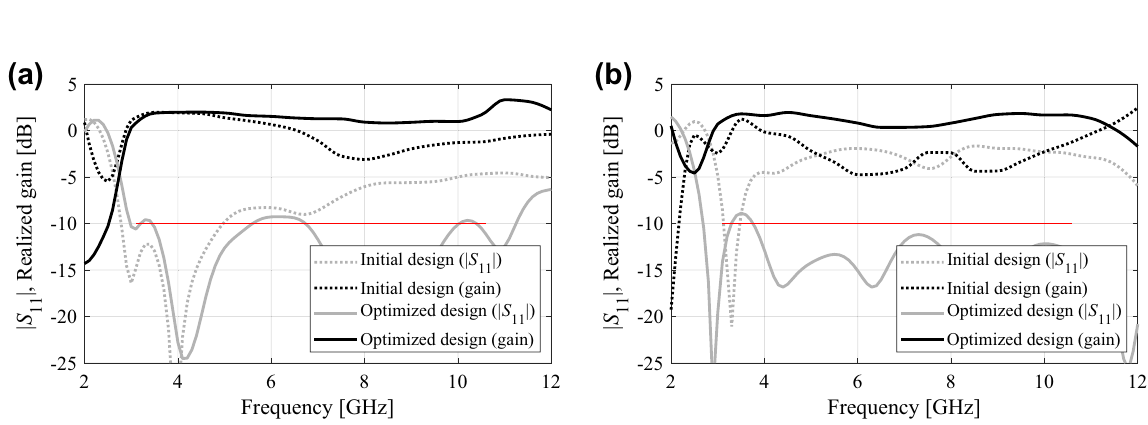
Figure 5. Selected optimization runs for Antenna I oriented towards gain variability reduction (cf. Table 6): initial design ( ⋅⋅⋅⋅ ), design optimized for minimum gain variability, (—), (a) absolute parameterization (gain variability 1.2 dB), (b) relative parameterization (gain variability 1.7 dB). Reflection and realized gain characteristics shown using gray and black lines, respectively. (Matlab R2016a https:// www. mathw orks.